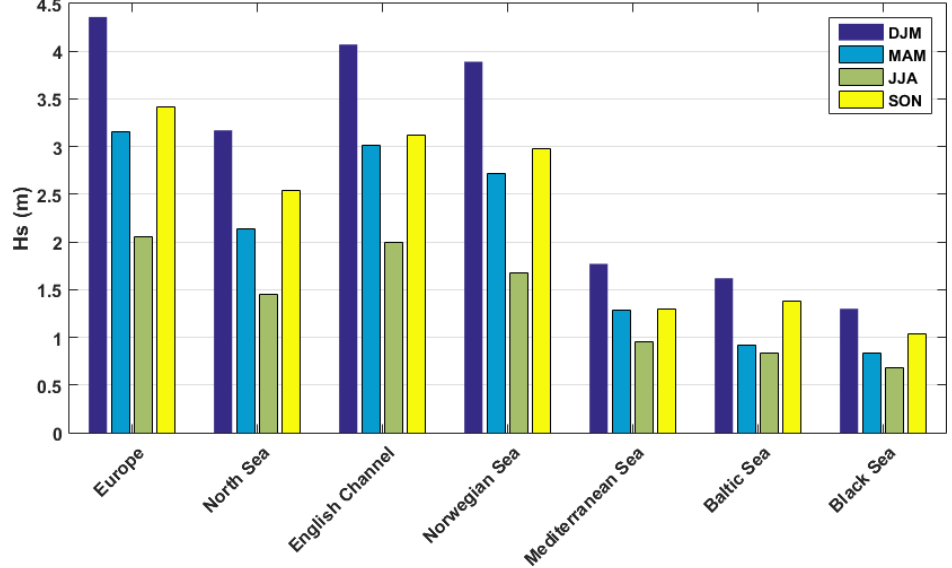
Figure 17. Seasonal characteristics 95th percentile of the mean Hs fields for each area considered. From Figures 15 and 17, it can be observed that the maximum value of Hs means and percentiles in summer (JJA) are half those encountered in winter (DJF), except in the North Sea where the difference between winter and summer values are even greater. In